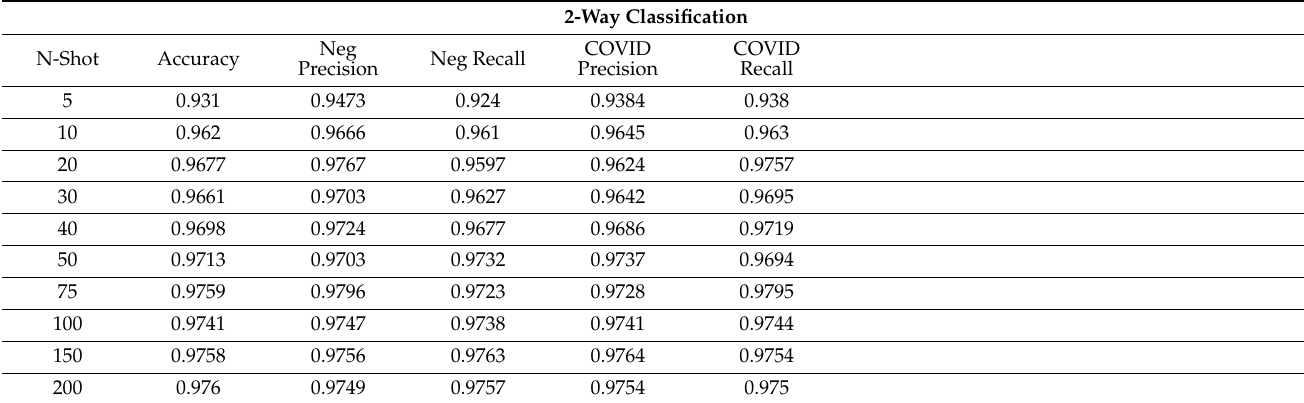
Table A3. Complete experiment results for